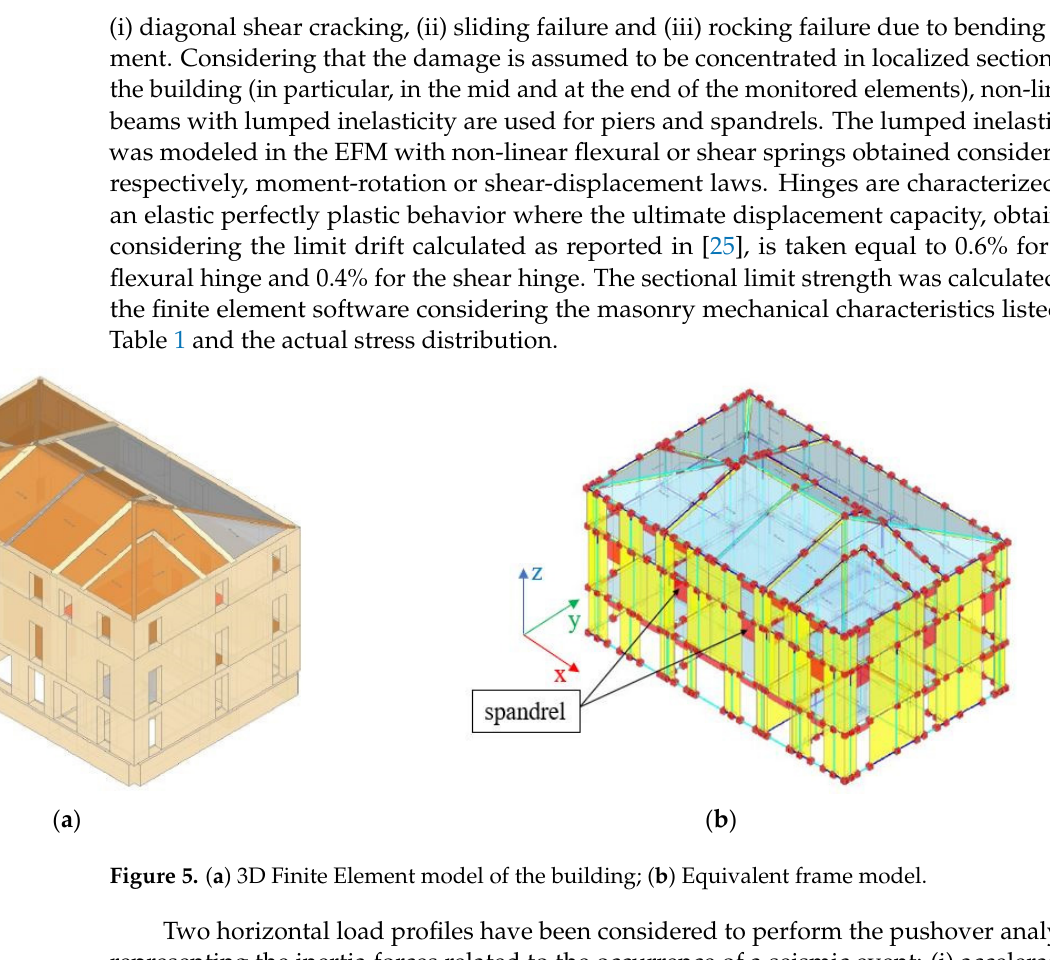
Figure 6. Capacity curves (current configuration).